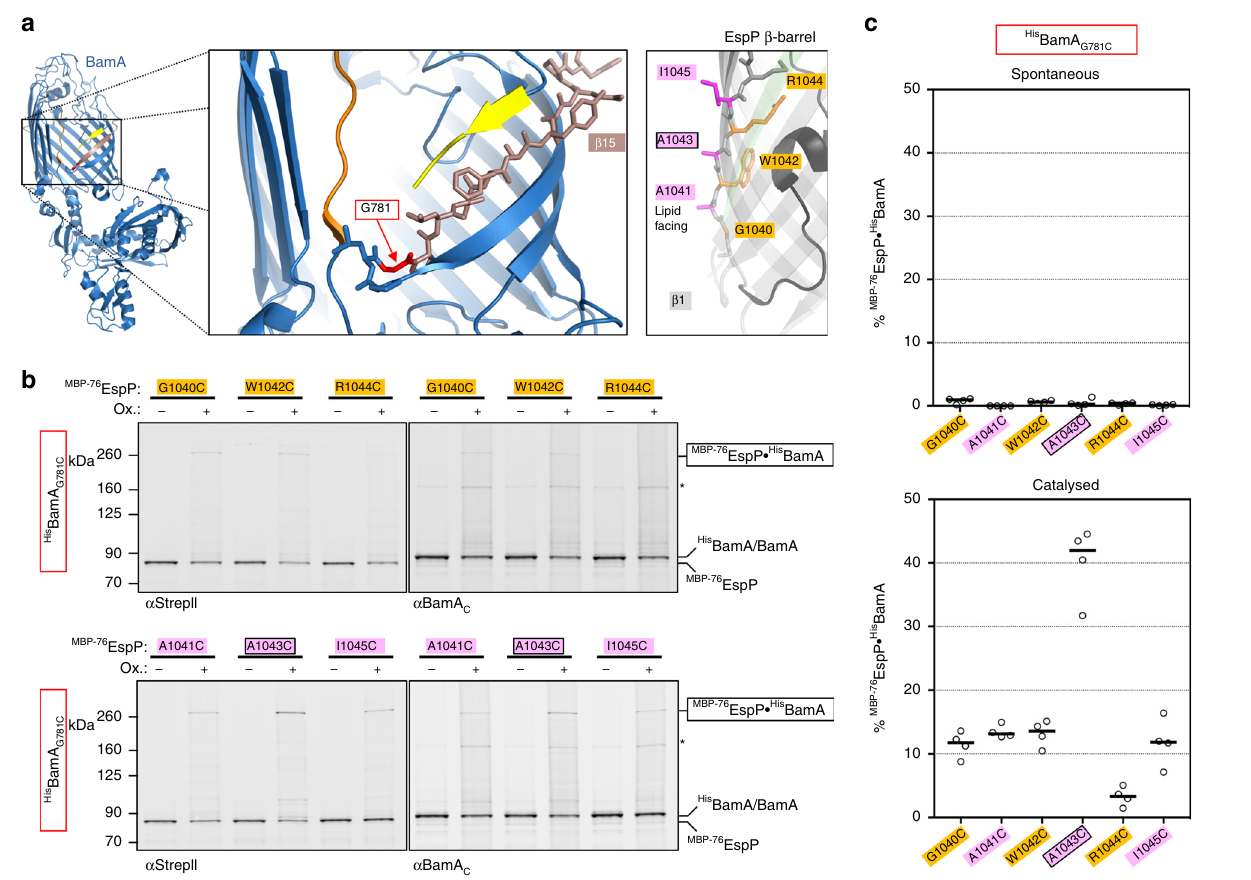
Fig. 5 Strong bond between a mid-strand MBP − 76 EspP( β 1) cysteine and a periplasmic-proximal BamA( β 15) cysteine. a Left, view of periplasmic-proximal BamA β -strand 15 residue G781 (red) in the lateral opening. Right, view of MBP − 76 EspP( β 1) showing lipid-facing (magenta) and luminal (orange) residues. b BL21(DE3) that expressed MBP − 76 EspP with a single cysteine substitution in β 1 and His BamABCDE with the His BamA G781C substitution were mock-treated ( − ) or treated with 4-DPS ( + ). Duplex-immunoblots were then conducted using antibodies/antisera against the N-terminus of MBP − 76 EspP ( α Strep II) and the C-terminus of His BamA ( α BamA C ) to monitor disul fi de-bond formation between cysteine pairs in vivo. Non-speci fi c bands are denoted (*). Data are representative of at least two independent experiments. c Quantitation of disul fi de-bond formation between MBP − 76 EspP( β 1) and His BamA G781C cysteine pairs in mock-treated cells ( ‘ spontaneous ’ ) and 4-DPS-treated cells ( ‘ catalysed ’ ). Experiments were performed as in b , except that only α StrepII was used for probing immunoblots. Bars = median, N = 4. ANOVA and multiple comparison tests are shown in Supplementary Table 5. Source data are provided as a Source Data fi